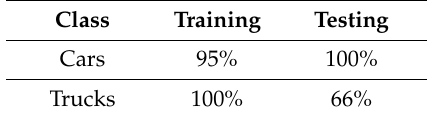
Table 5. Cars and trucks with LLM training and testing prediction accuracy.